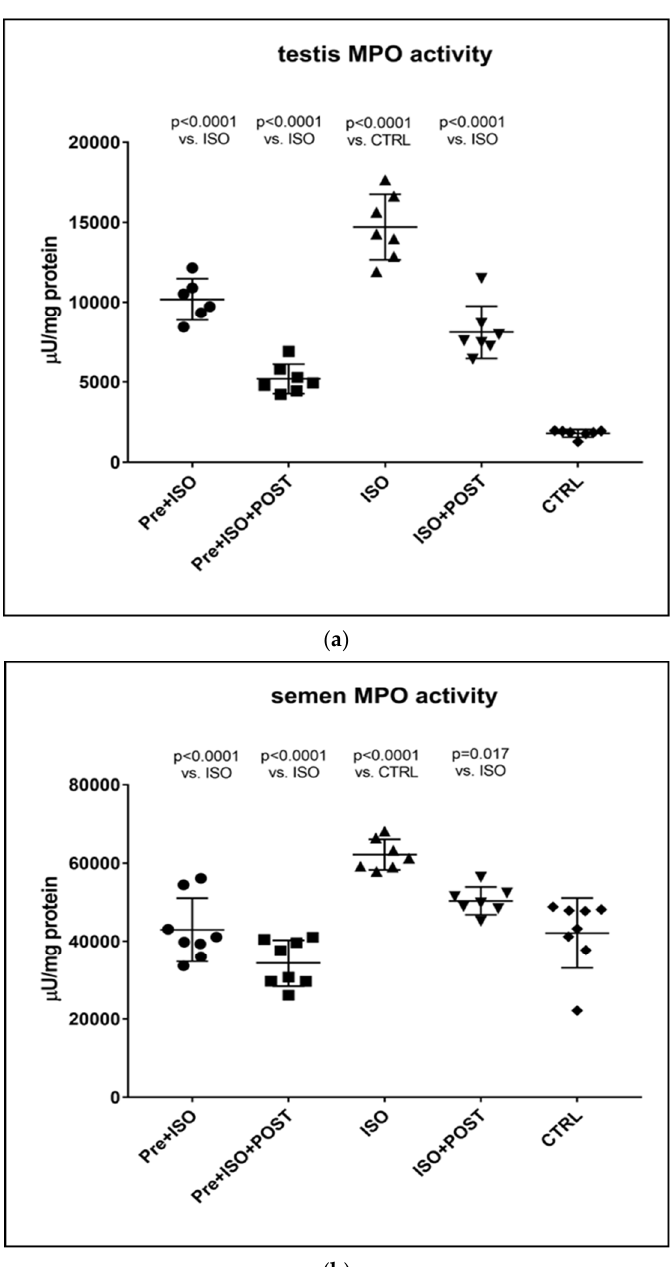
Figure 5. ( a ) The effects of isoproterenol treatment and exercise training on testicular myeloper- oxidase (MPO) enzyme activity (expressed as: µ U/mg protein). ( b ) The effects of isoproterenol treatment and exercise training on myeloperoxidase (MPO) enzyme activity of the semen, expressed as µ U/mg protein. The results are shown as mean ± S.D., n = 6–8/group, one-way ANOVA, Tukey’s post-test. Significant differences between treatment groups are shown with exact p values. PRE = Pre-swimming, ISO = Isoproterenol injection, POST = Post-swimming, CTRL = Control group, MPO = myeloperoxidase